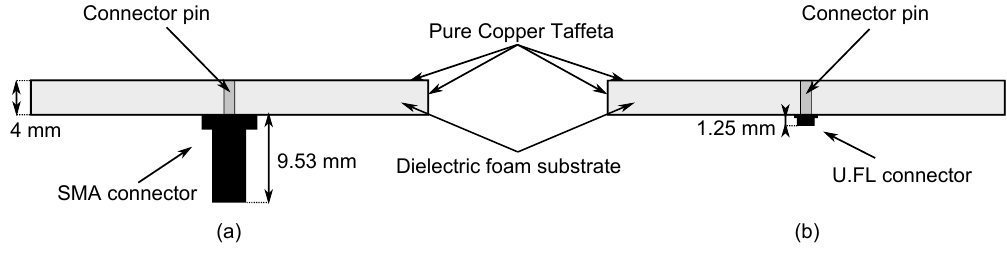
Figure 2. Cross-section of the textile ultra-wideband SIW antenna with SMA connector ( a ) and U.FL connector ( b